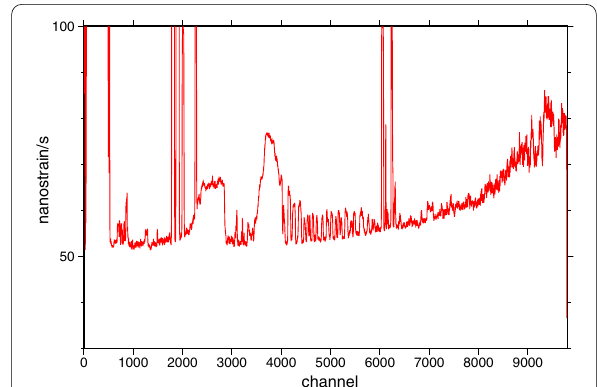
Fig. 2 Standard deviation of observation at each channel. Median values of standard deviation of strain rate, measured for each